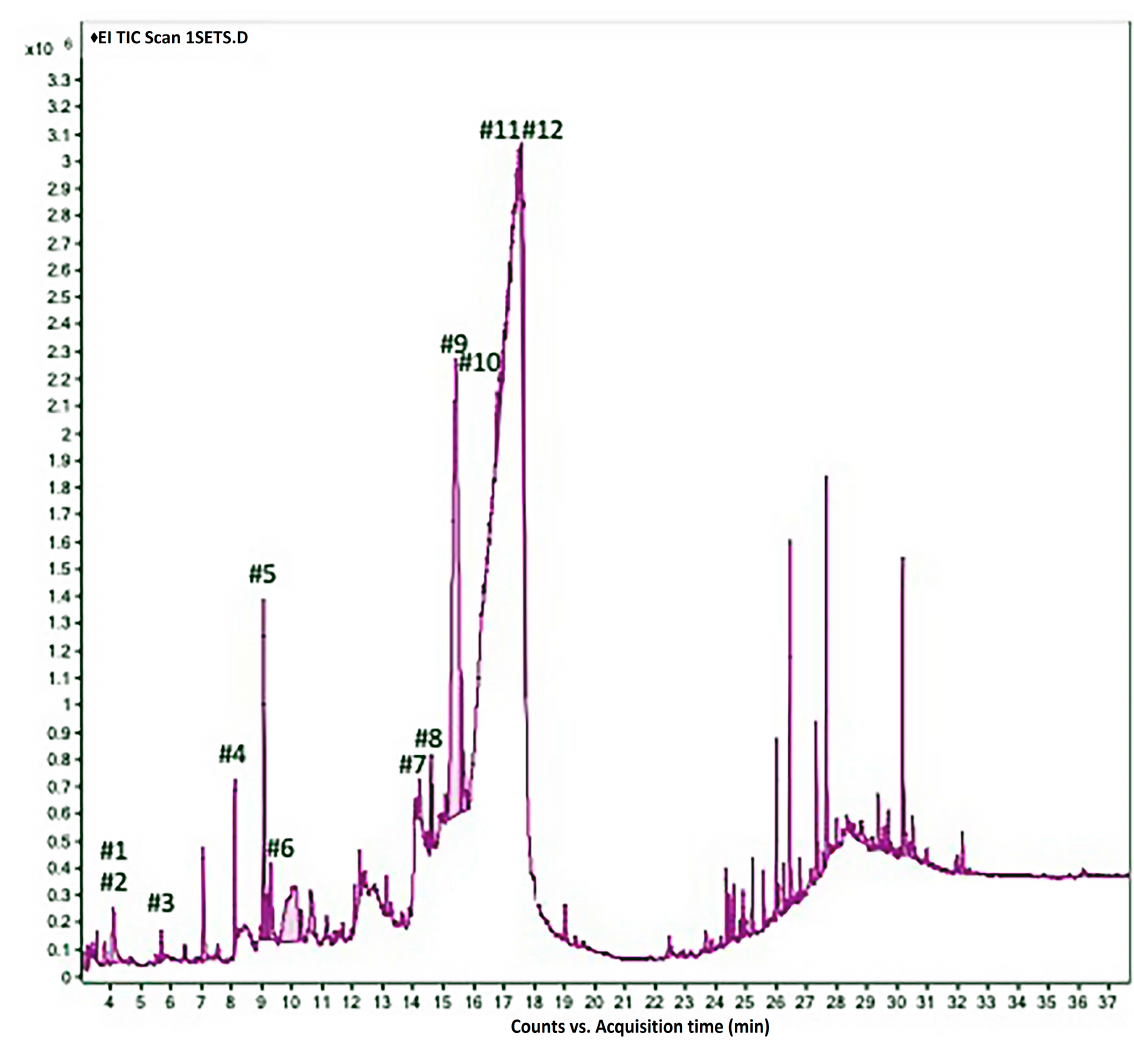
Figure 2. GC/MS chromatogram of J. procera methanol leaf extract. Table 2. Identification of the bioactive components in J. procera methanol leaf extract using GC/MS.